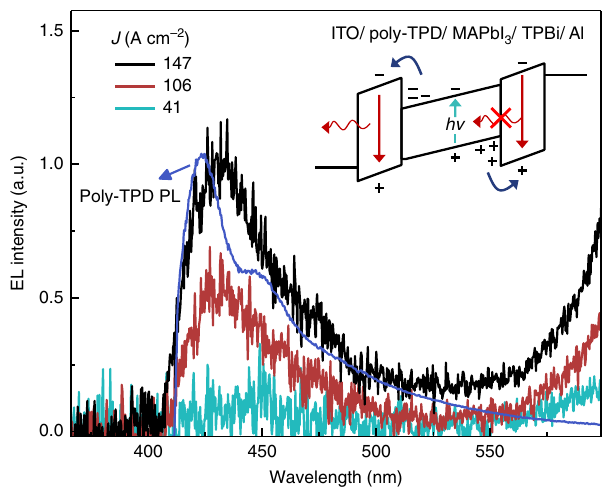
Fig. 7 Evidence of charge imbalance. Electroluminescence spectra at high current density, demonstrating blue poly-TPD emission due to electron leakage out of the perovskite emissive layer as shown in the inset. Emission at wavelengths below 410 nm is cut off due to the use of a long-pass fi lter and the photoluminescence spectrum of poly-TPD (blue line) is overlaid for comparison